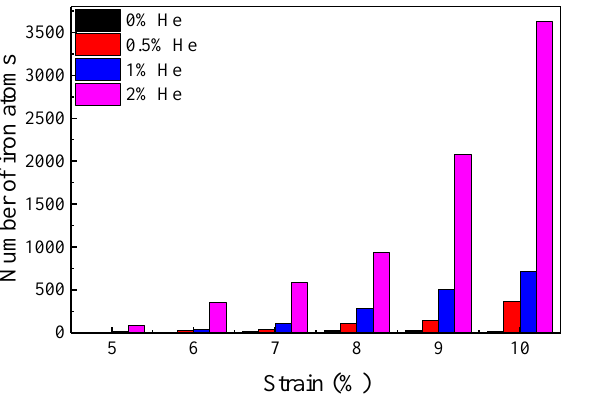
Figure 2. The number of Fe atoms near the biggest crack as a function of strain. No cracks are found during 0–4% straining.